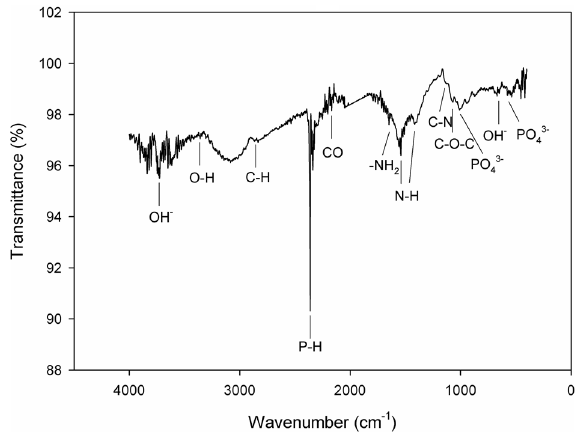
Figure 2. FTIR spectra of the chitosan-based MAO